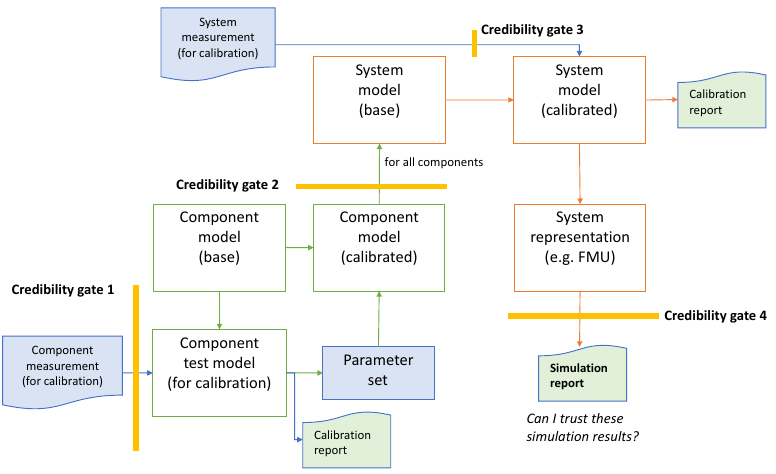
Figure 6. Schematic calibration process of a system